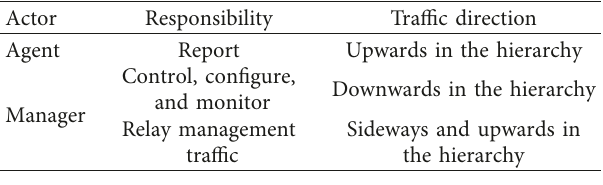
Table 1: Management role-based responsibilities in the hierarchy.